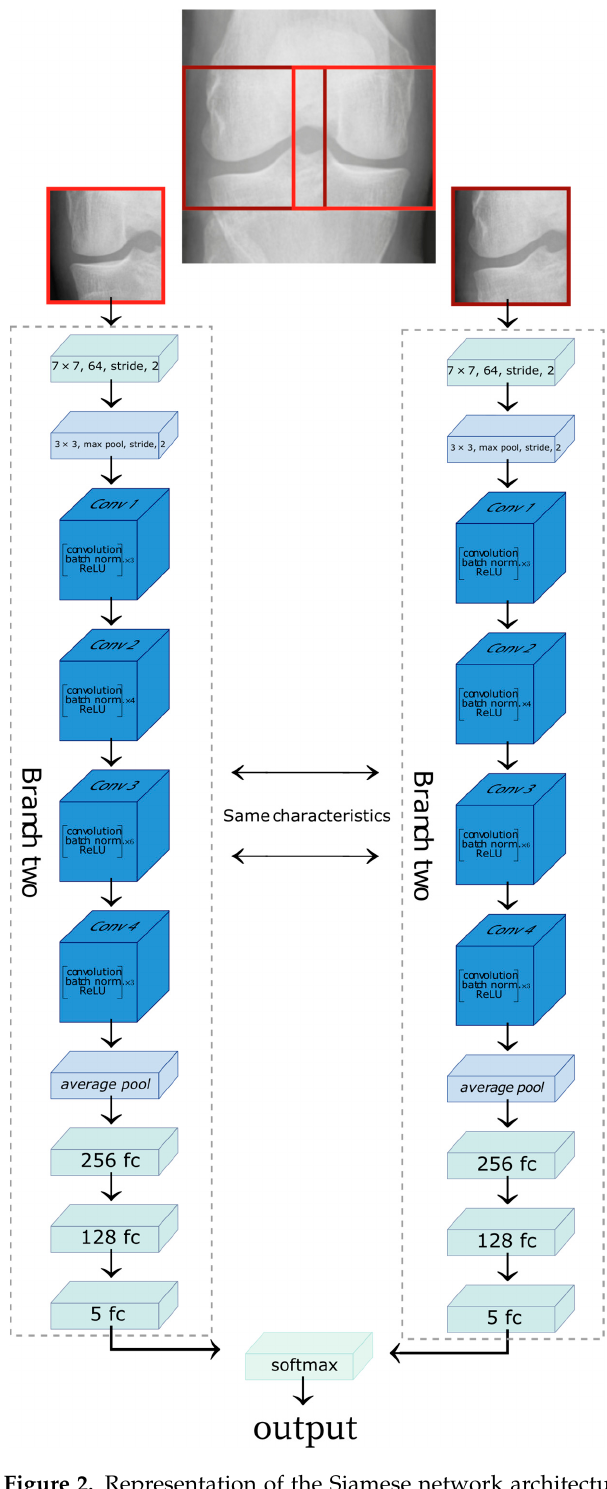
Figure 2. Representation of the Siamese network architecture. The lateral side of the knee X-ray image feeds one branch of the network, and the medial side of the knee X-ray image provides the second branch of the network. The figure was adapted from